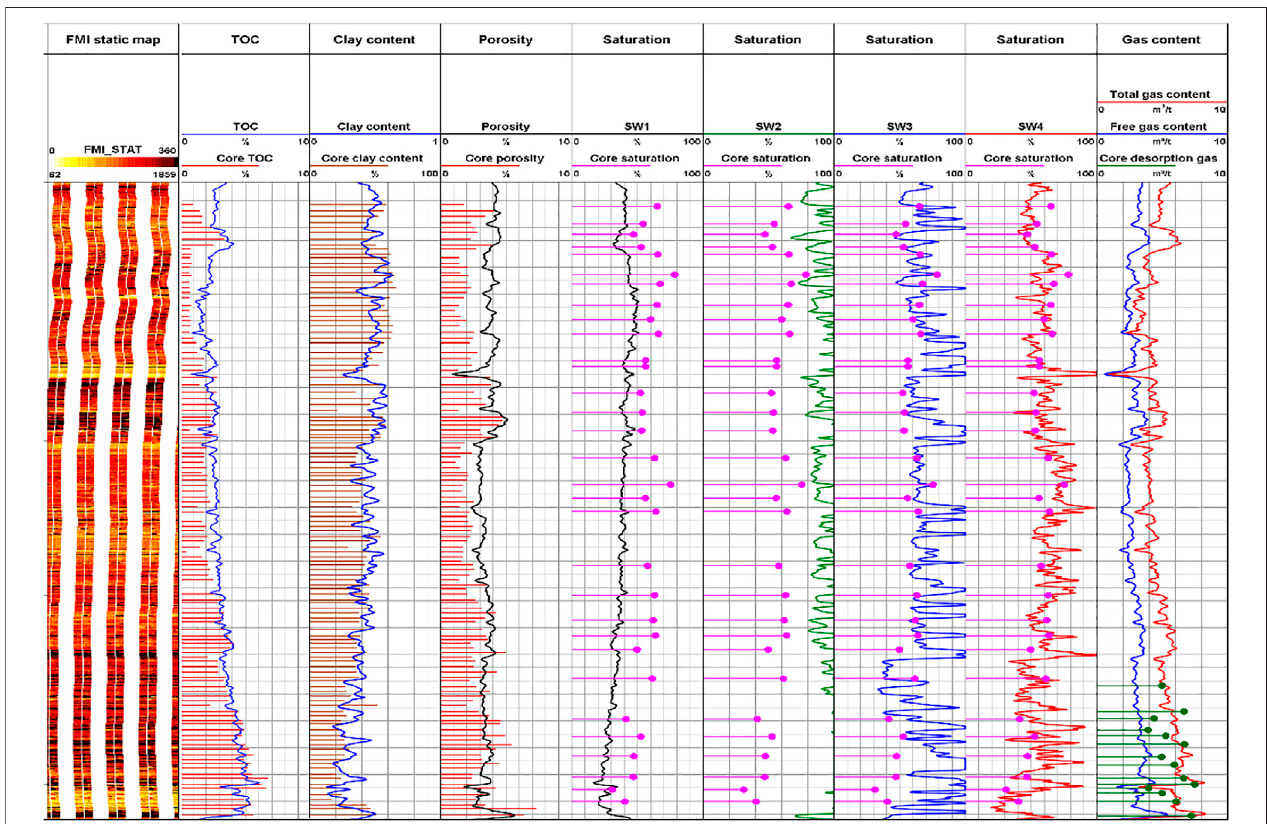
FIGURE 16 | Well logging interpretations of marine shale gas well J9, Sw4 is new model, Sw1-Sw3 are old models.